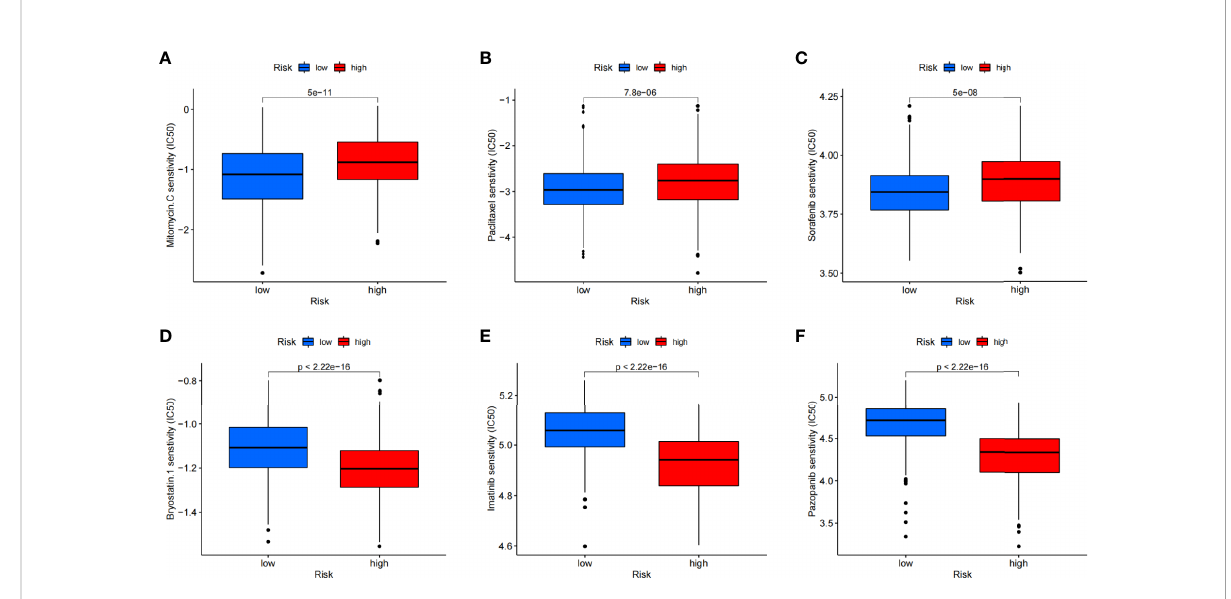
FIGURE 10 Relationships between CAFS-score and medicine sensitivity. Lower IC50 of indicated chemo-therapeutics drugs in low (A – C) and high (D – F) CAFS-score group,